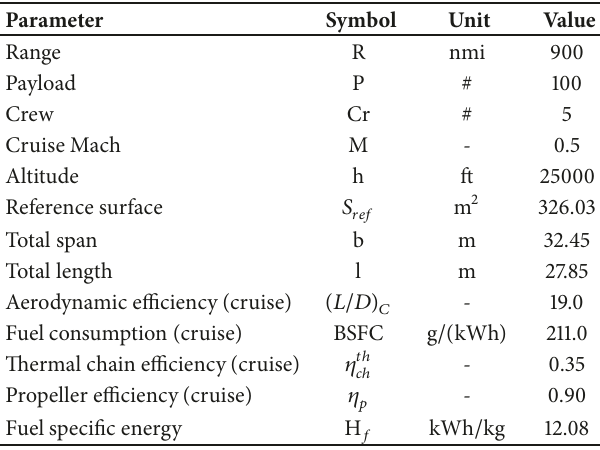
Table 1: Mission requirements and relevant